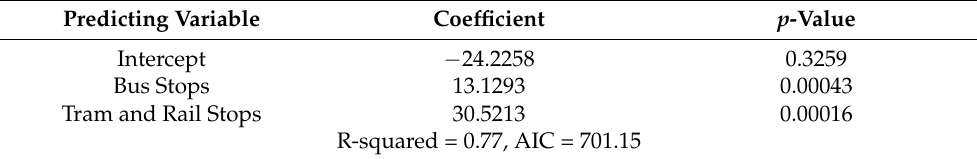
Table 1. Parameter results of OLS